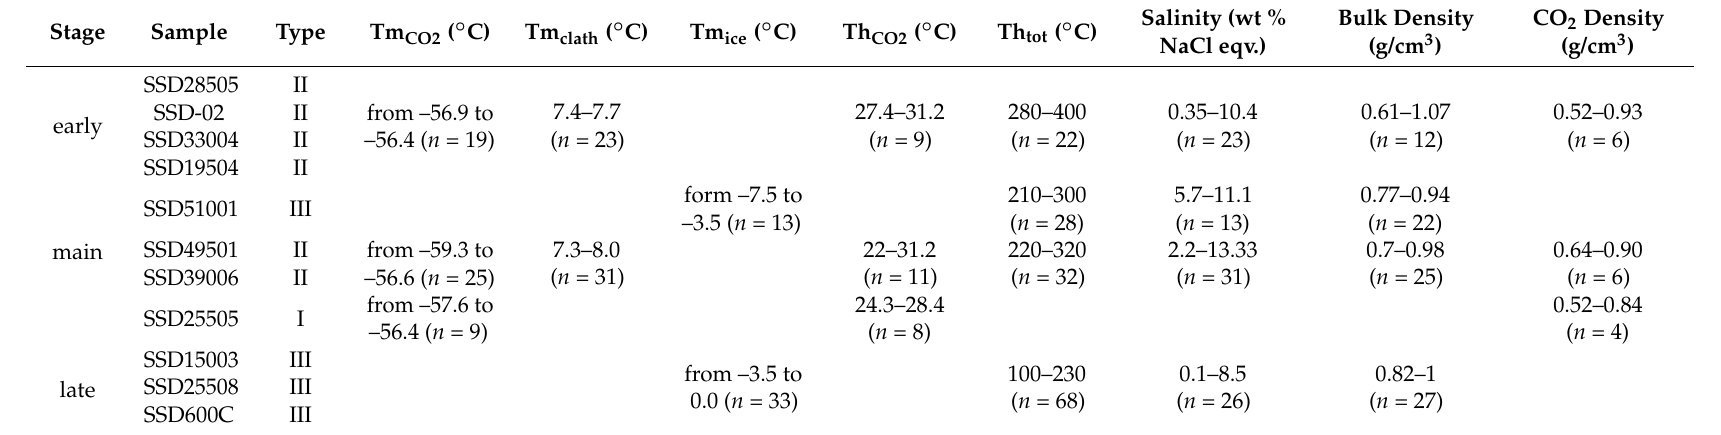
Table 2. Summary of the microthermometric data for fluid inclusions trapped in quartz and calcite from the Sanshandao gold